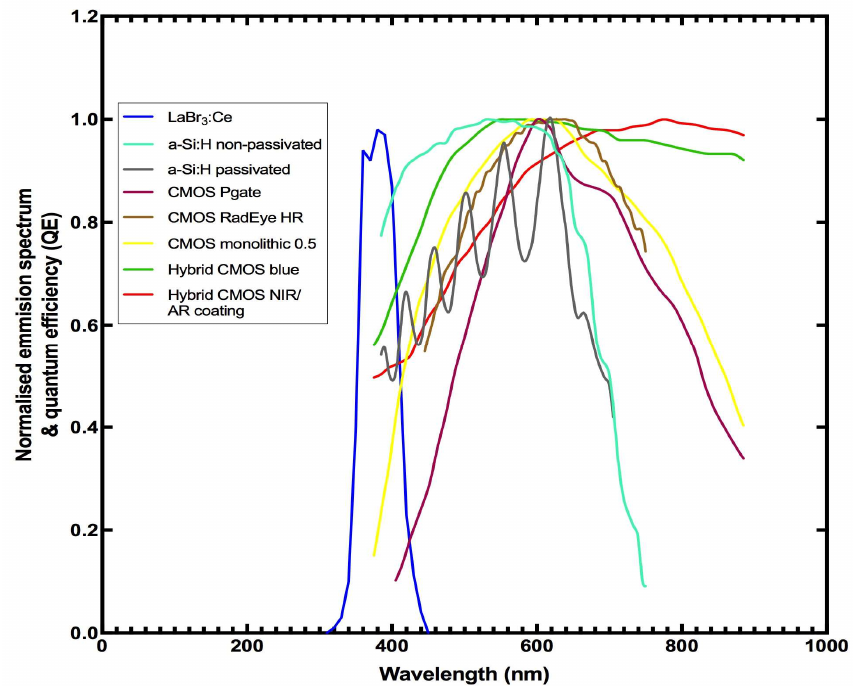
Figure 8. Optical spectral distribution of LaBr 3 :Ce crystal, and spectral sensitivity of CMOS photo- receptors.